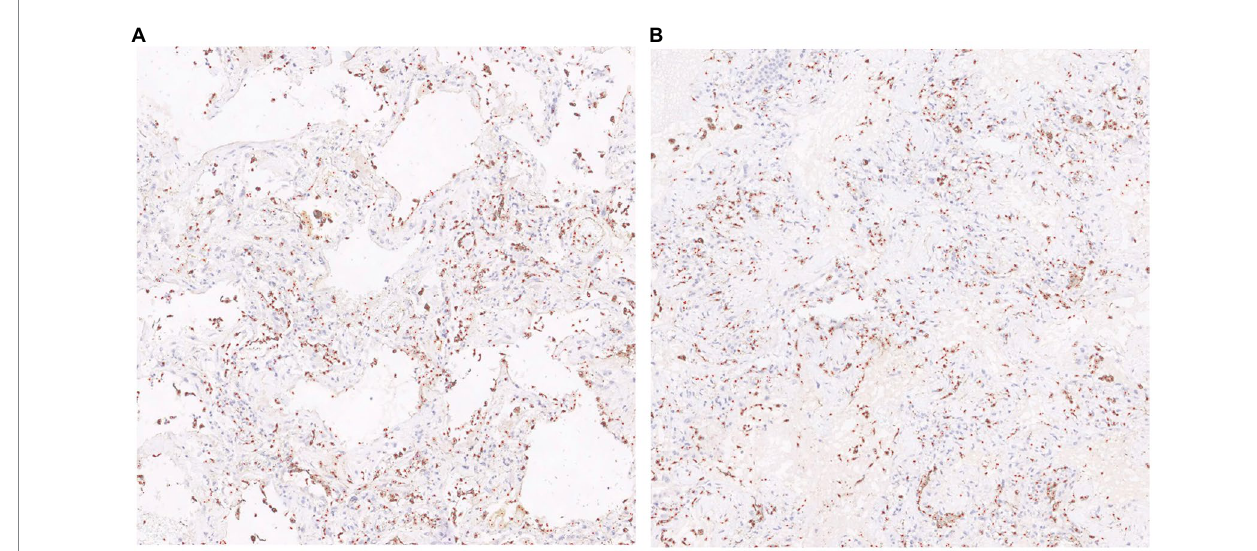
FIGURE 7 Visualization of cell prediction results (red dots are predicted cell locations). A :The patch contains some white regions; B :The patch only contains tissue.